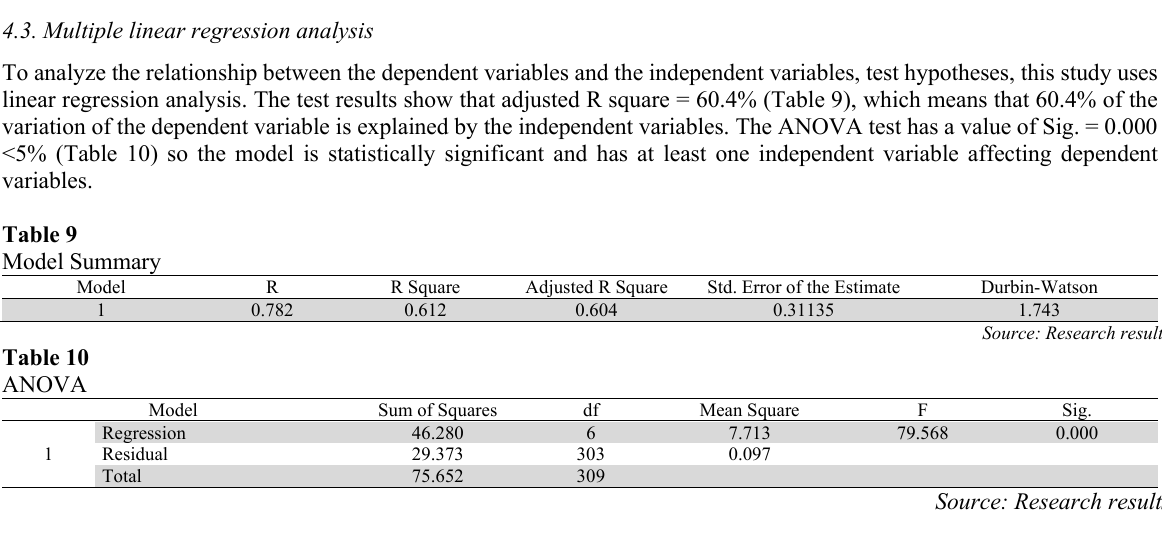
The coefficients of the regression analysis Model